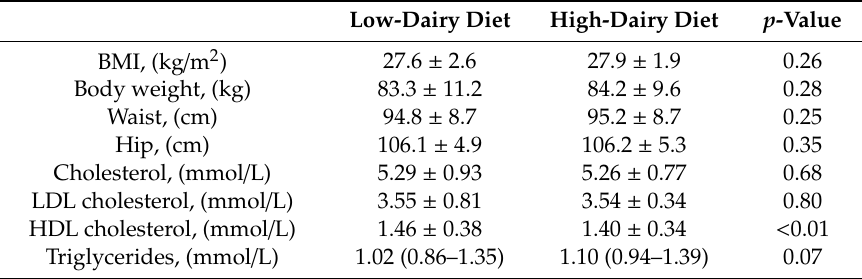
Table 1. Subject